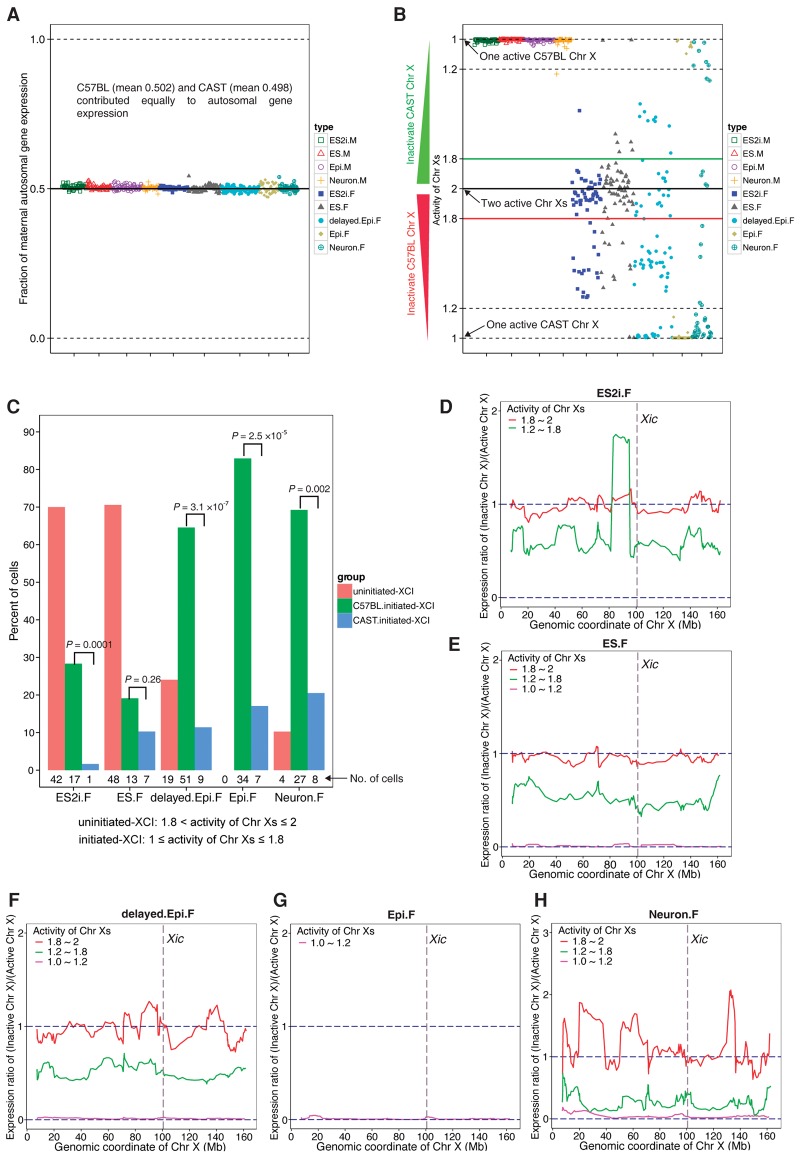
Dynamic and heterogeneous XCI states in female cells. (A) Fraction of maternal expression for autosomal genes in each condition of cells. Fraction of maternal expression was calculated using maternal allelic reads divided by the sum of maternal and paternal allelic reads. (B) Activity of maternal and paternal X Chromosomes in each condition. The indexes of the activity of Chr Xs in female cells range from 1 (one active X Chromosome) to 2 (two active X Chromosomes). Each type of female cell was divided into three different XCI groups: (1) uninitiated-XCI (1.8< activity of Chr Xs ≤2); (2) ongoing-XCI (1.2< activity of Chr Xs ≤1.8); and (3) completed-XCI (1≤ activity of Chr Xs ≤1.2). (C) The percentage of cells in each XCI group for each condition. Because it is not possible to determine whether the uninitiated-XCI cells are going to inactivate the maternal or paternal X Chromosome, Student's t-test was only applied to the cells of the initiated (ongoing and completed) XCI group. (D–H) Chromosome-wide expression ratio of inactive X Chromosome compared to active X Chromosome. The ratio was calculated using the number of allelic reads of inactive X Chromosome divided by that of active X Chromosome based on a moving window of an average of 10 genes. Red, green, and magenta lines denote the female cells in uninitiated-, ongoing-, and completed-XCI groups, respectively.